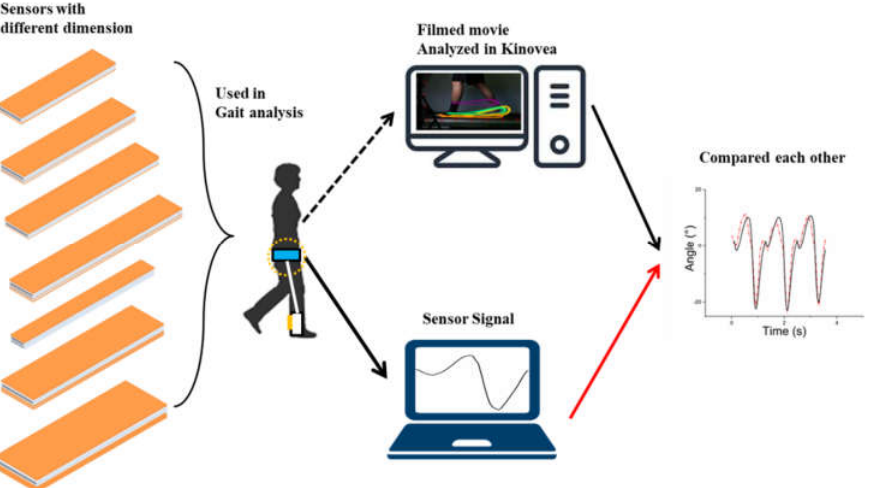
Figure 1. Main concept of this study. The subject walks on a treadmill with the sensor on the ankle. The walking procedure is filmed by a DSLR camera and analyzed on a PC through Kinovea. At the same time, the sensor signal is directly received by another computer. A total of seven procedures were carried out using sensors with different dimensions.